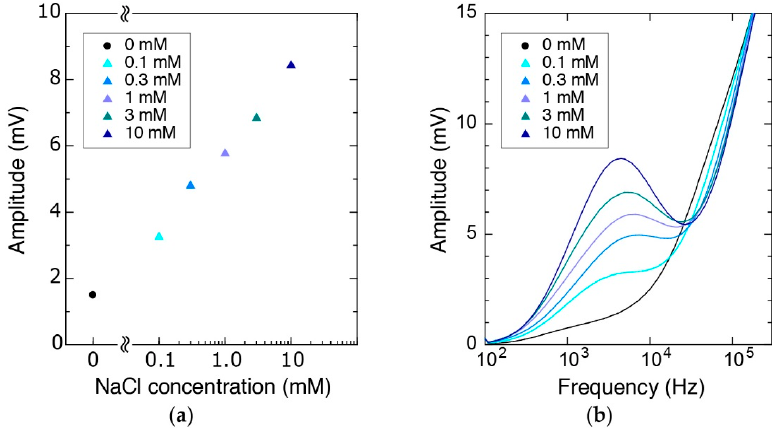
Figure 10. The amplitude of the signal ( a ) at 4 kHz and ( b ) during sweeping the frequency in different conditions.